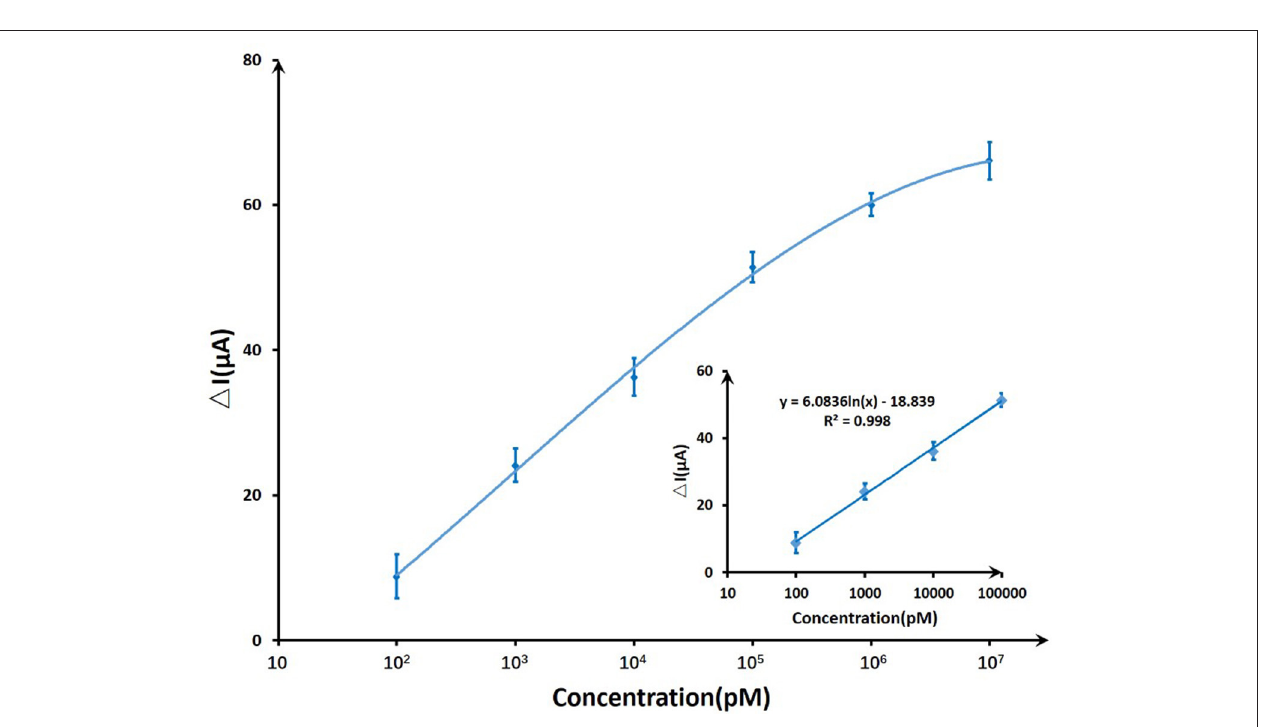
Frontiers in Chemistry |